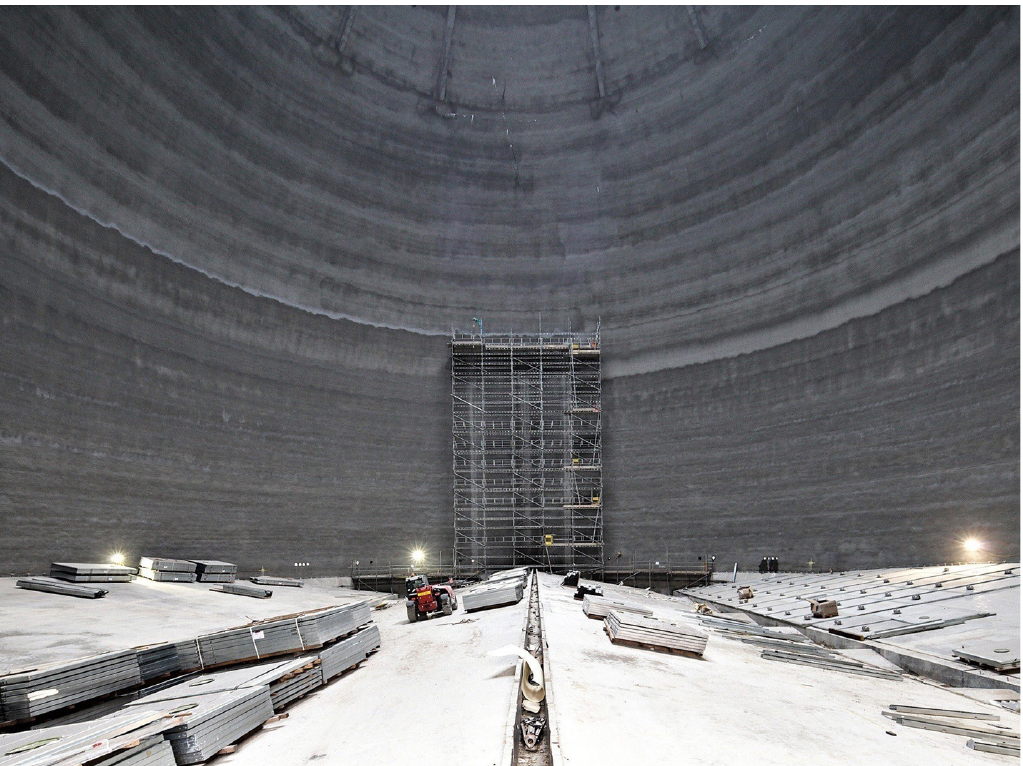
Figure 2. Dome silos under construction at the 20 Power Station in Selby, North Yorkshire, England. Source: Dome Technology (2021).